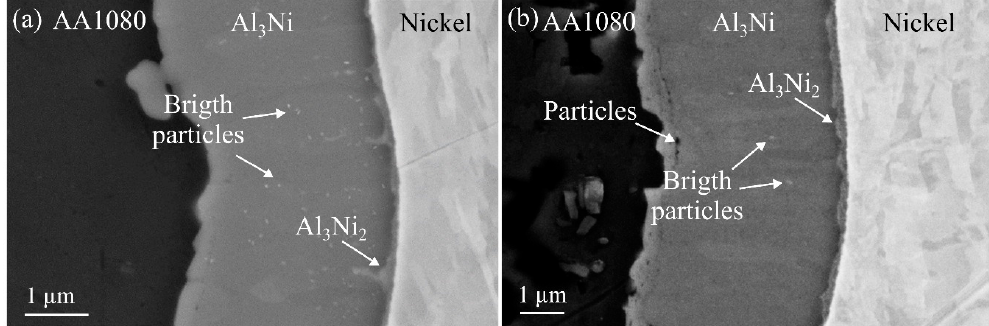
Figure 6. High magnification SEM images of Al 3 Ni phase along the aluminum-nickel interface after post-rolling heat treatment at 450 ◦ C for ( a ) one hour and ( b ) two hours. The initial growth of the second phase, Al 3 Ni 2 can be observed along the Al 3 Ni-nickel interface, and small bright particles can be observed inside the Al 3 Ni layer in ( a ). In ( b ) a line consisting of many particles can be observed inside the Al 3 Ni layer close to the interface towards the aluminum layer.